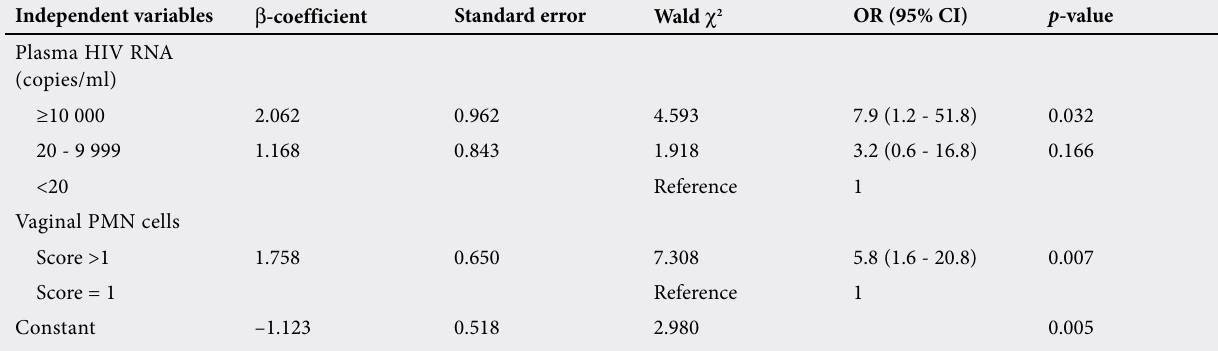
Table 5. Independent determinants of HIV RNA detectability in GT of HIV-infected women receiving HAART * ( N =60) Independent